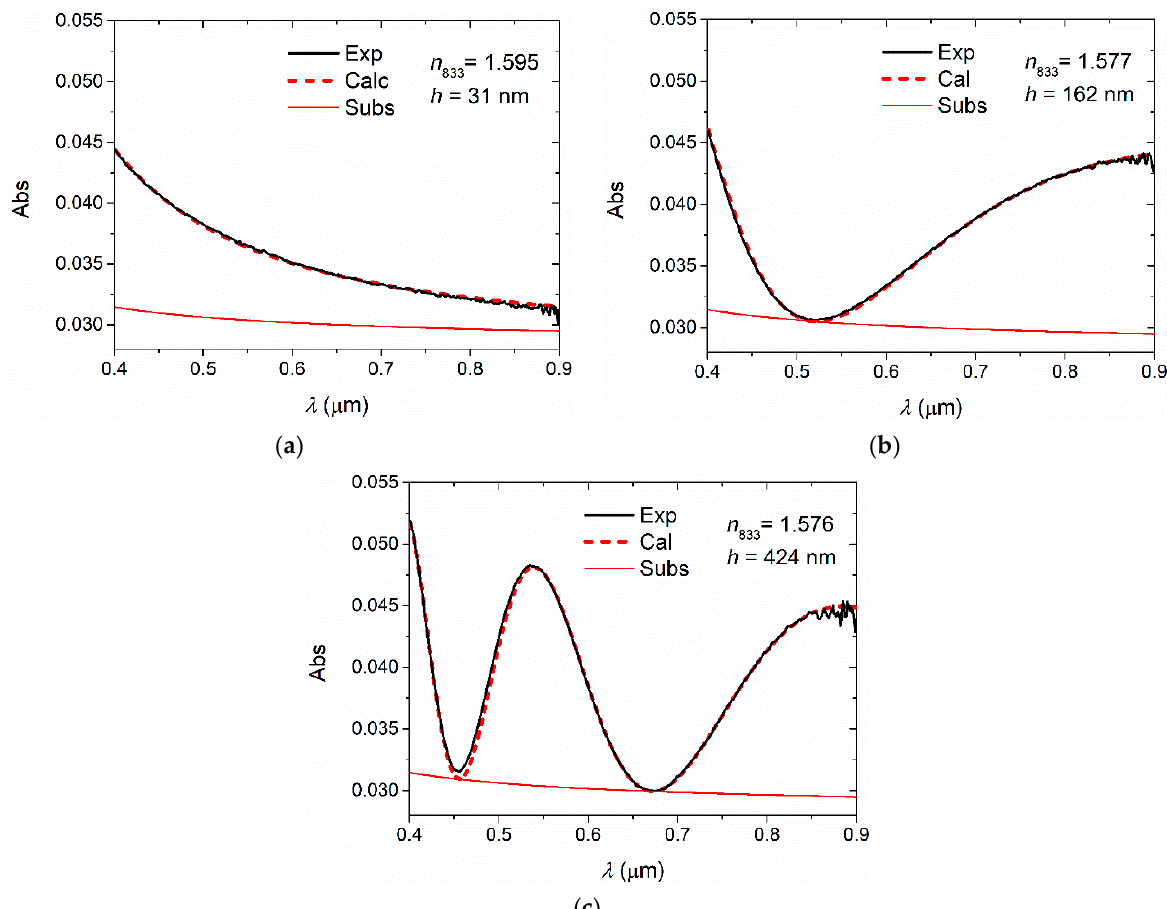
Figure 3. Experimental absorption spectra against air (black solid lines) and calculated interference patterns (red thick dashed lines) corresponding to PS films: ( a ) PS 0.9%, ( b ) PS 3.0%, and ( c ) PS 8.0%. The substrate spectrum Equation (6) has also been included (red solid